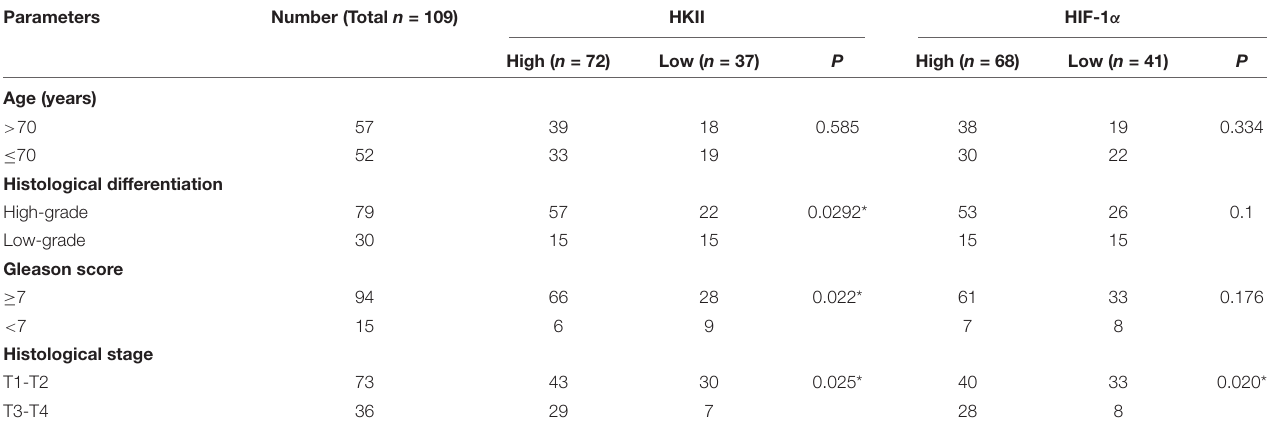
TABLE 1 | Clinicopathological features of prostate cancer in relation to HKII and HIF-1 α protein expression.